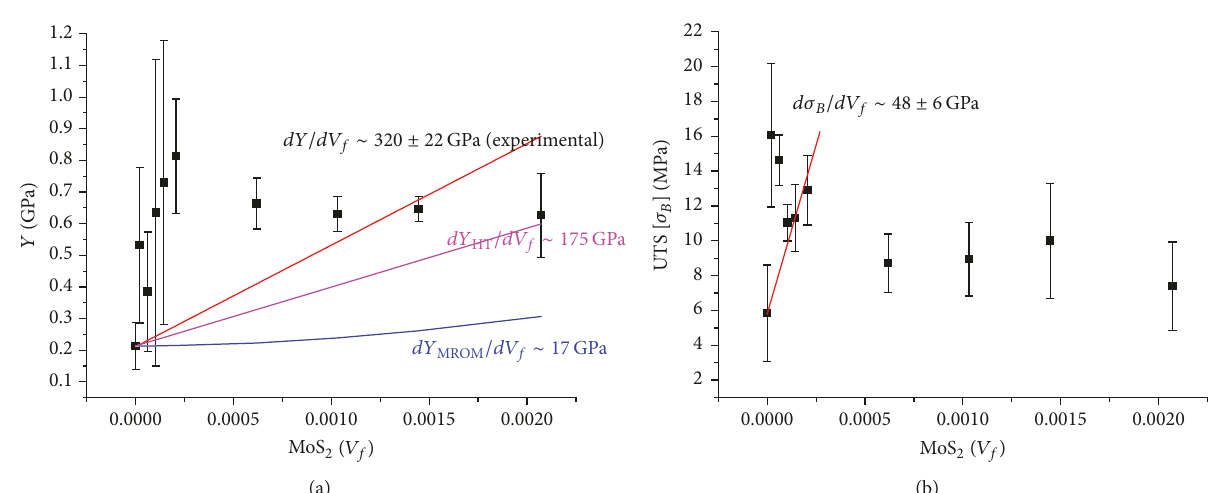
Figure 3: Modulus and ultimate tensile strength of MoS 2 -PS composites as a function of MoS 2 volume